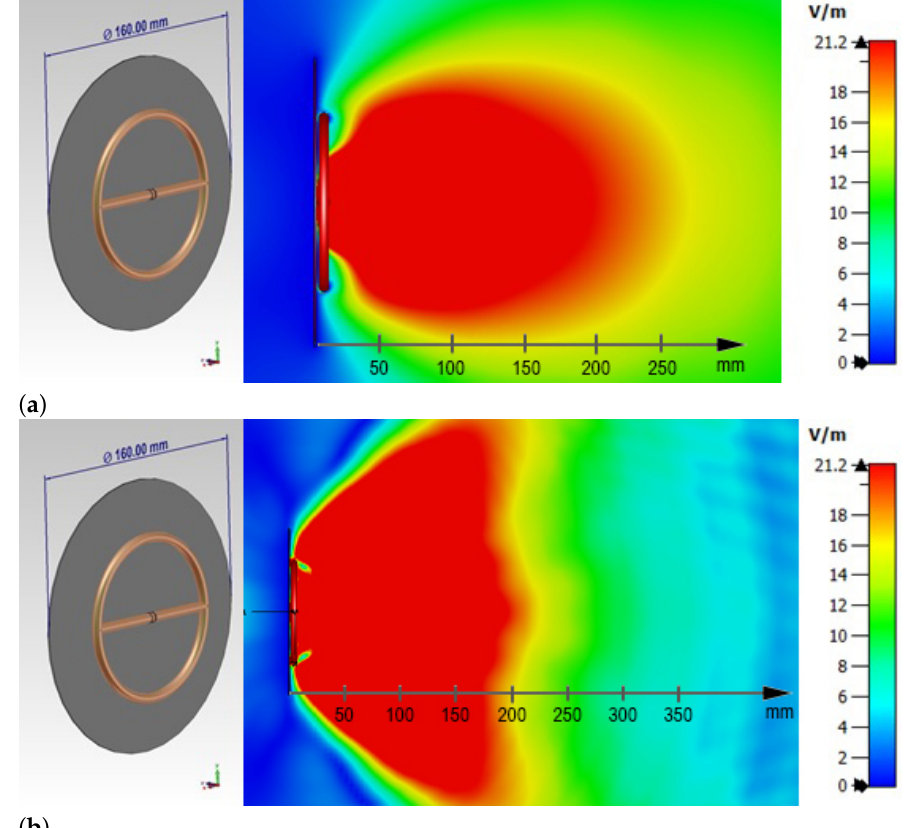
Figure 1. CST model of a near-field microwave probe (left). Electric field distribution of the near-field probe at a frequency of 2 GHz ( a ) and 10 GHz ( b